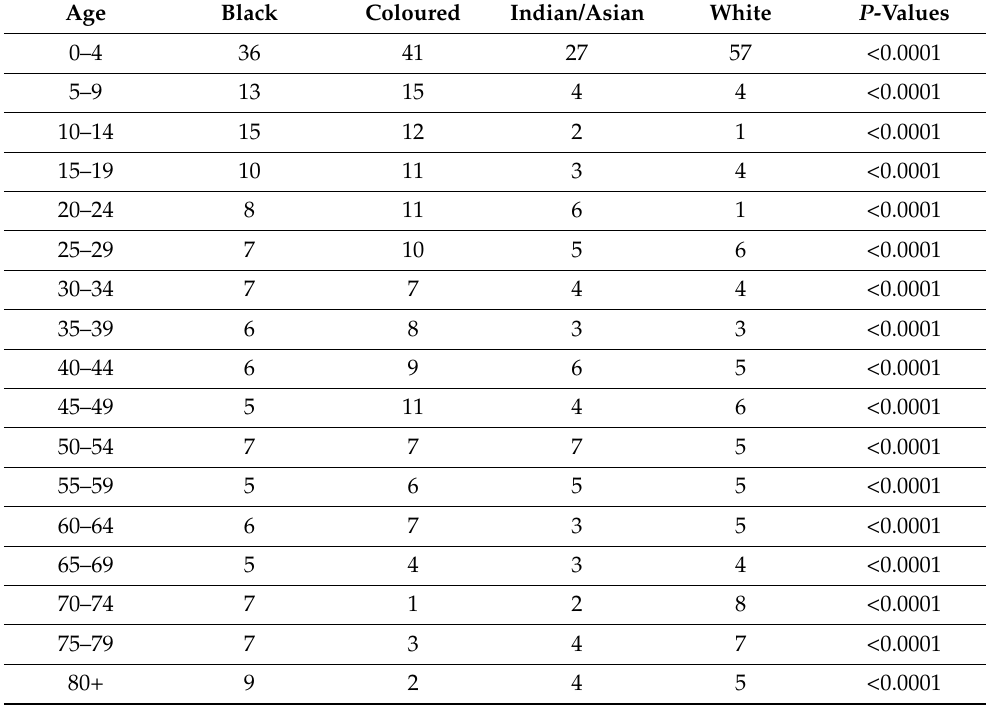
Table 4. Age-specific and ethnicity-specific drowning rates in South Africa,